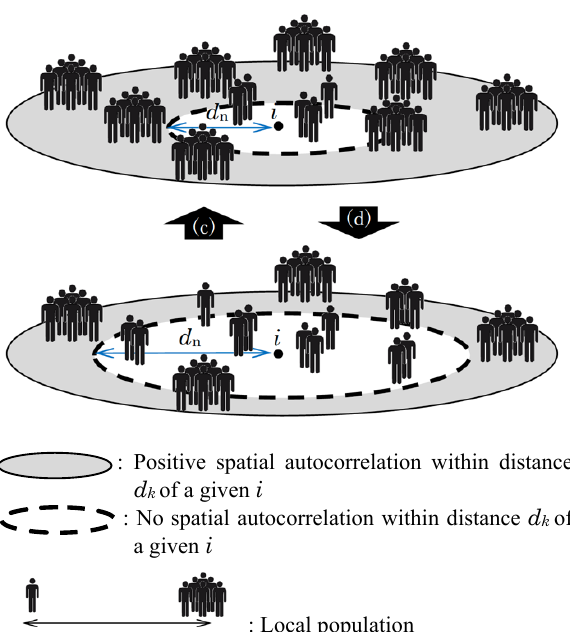
Figure 9 . Conceptual diagram with respect to the detection of the fluctuations of ASP.